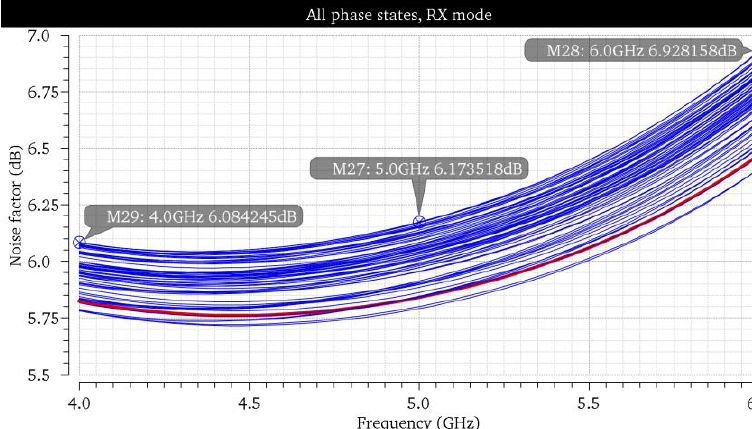
Fig. 6. Frequency dependence of the absolute phase error from the control code in Tx mode.